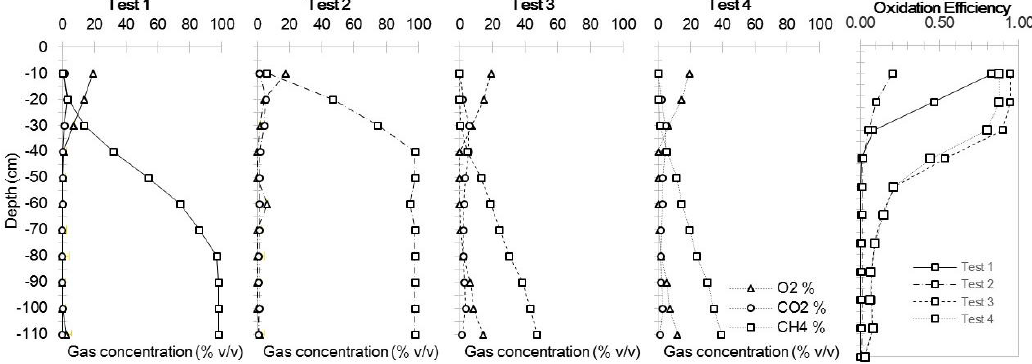
Figure 7. Average gas composition profiles and methane oxidation efficiencies in the column tests.